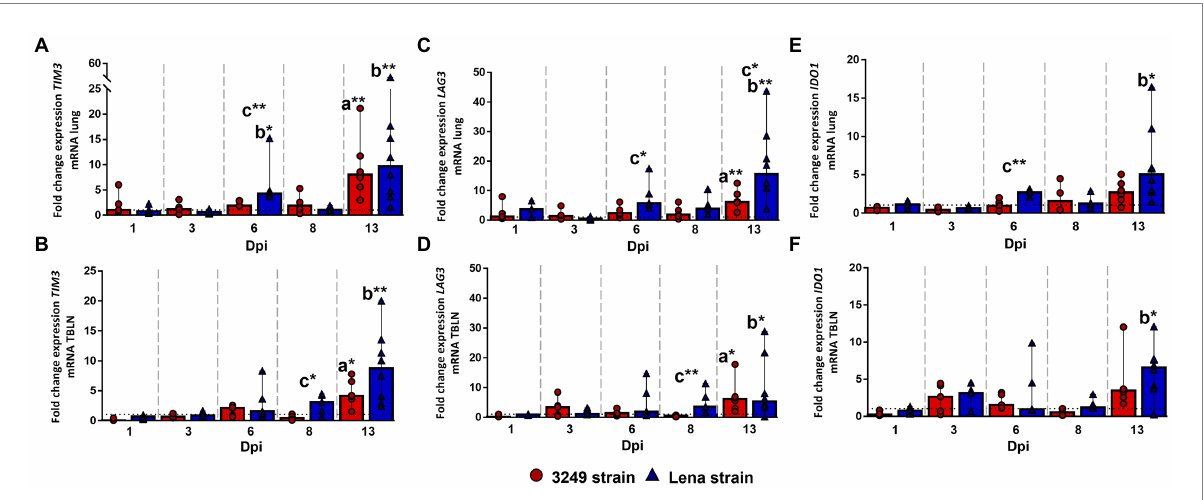
FIGURE 6 Relative mRNA expression of TIM3 , LAG3 and IDO1 mRNA. Graphs show fold change expression of TIM3 mRNA in lung (A) and tracheobronchial lymph node (TBLN) (B) , of LAG3 mRNA in lung (C) and tracheobronchial lymph node (TBLN) (D) , and of IDO1 in lung (E) and tracheobronchial lymph node (TBLN) (F) . Columns represent median with interquartile range (IQR). Individual values for each animal from low virulent 3249- (red circles) and virulent Lena- (blue triangles) infected animals are showed. Dashed line represents the expression of TIM3 , LAG3 and IDO1 mRNA from control group in each organ. “a” indicates a significant difference between the 3249 and control groups, “b” between Lena and control groups and “c” between Lena and 3249 groups (* p ≤ 0.05 and ** p ≤ 0.01). Dpi, days